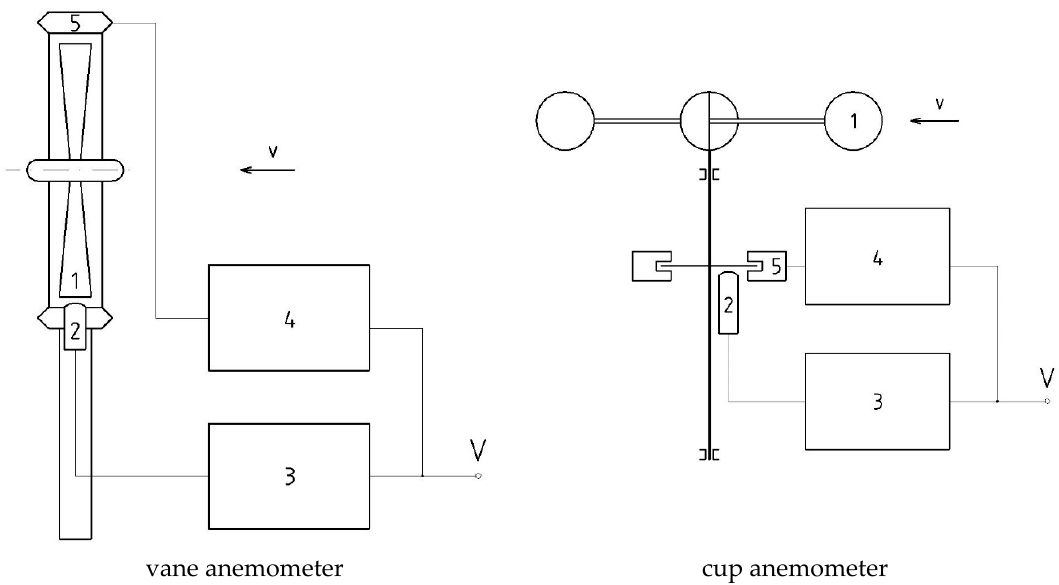
Figure 1. A system for optimization of dynamic properties of anemometers with rotating Figure 1. measuring element.